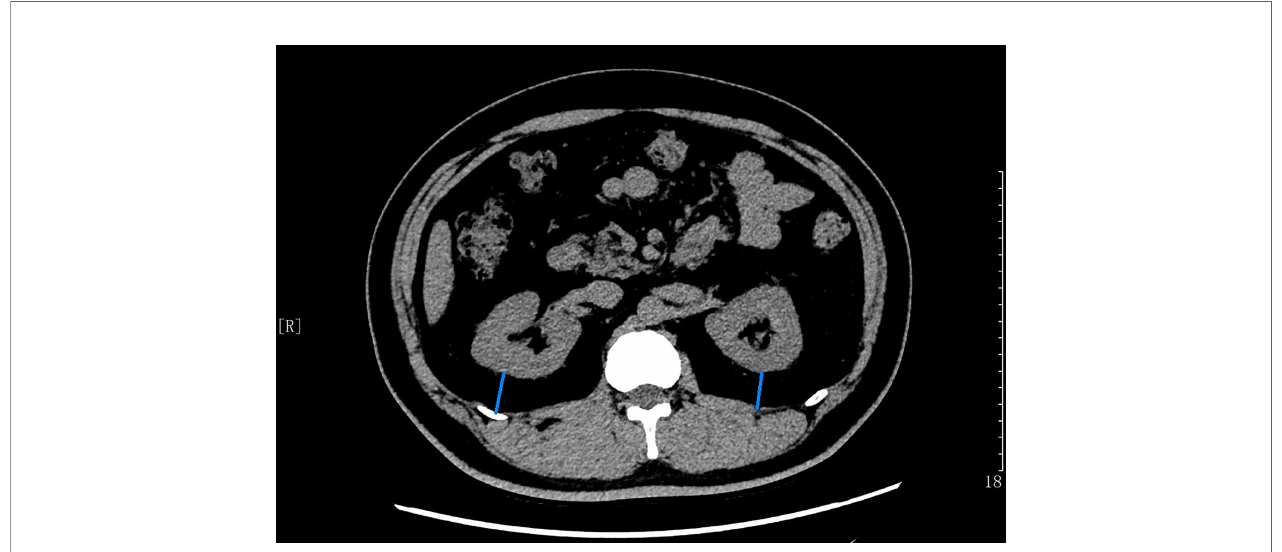
FIGURE 1 | The average of maximal thickness values (blue line) between the posterior wall of the kidney and the inner limit of the abdominal wall across the renal venous plane was calculated as the